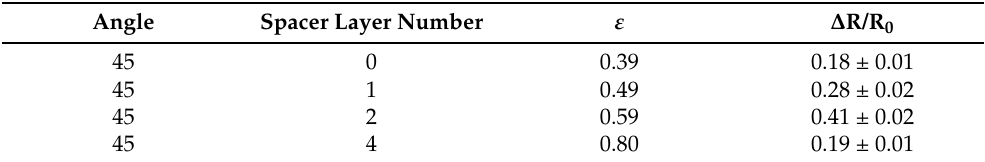
Figure 7. ( a ) The schematic of the index finger during bending at 45 degree and ( b ) representation of the finger as two beams with a cylindrical joint. Table 3. The effect of spacer layer number on resistance changes at an angle of 45° for Version 1